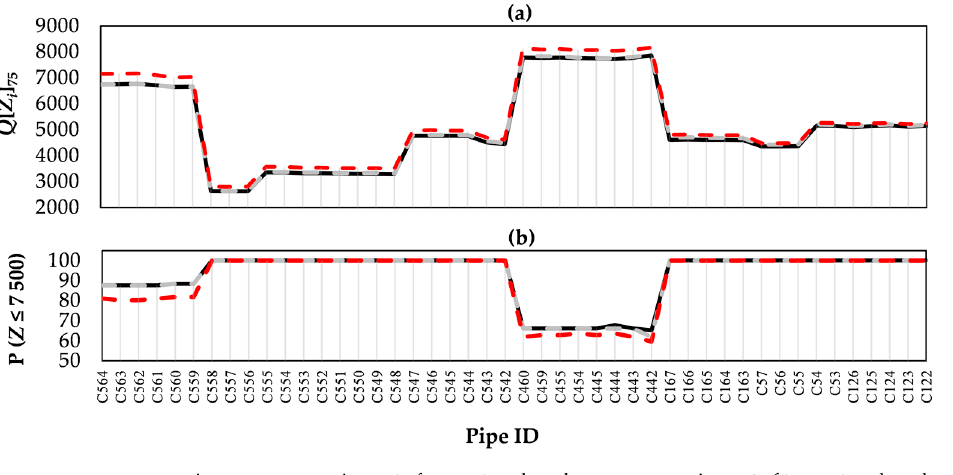
Figure 12. Hydrogen sulfide production across the optimal pipe path of area ID 22 in cases of different pumping approaches. ( a ) The first panel shows Q [ Z i ] 75 values in all pipes of the path; ( b ) The second panel depicts the non-exceedance probability of the Z ≤ 7500 threshold with respect to the path’s pipes. Both panels concern steady-rate pumping for a twenty-four-hour period.